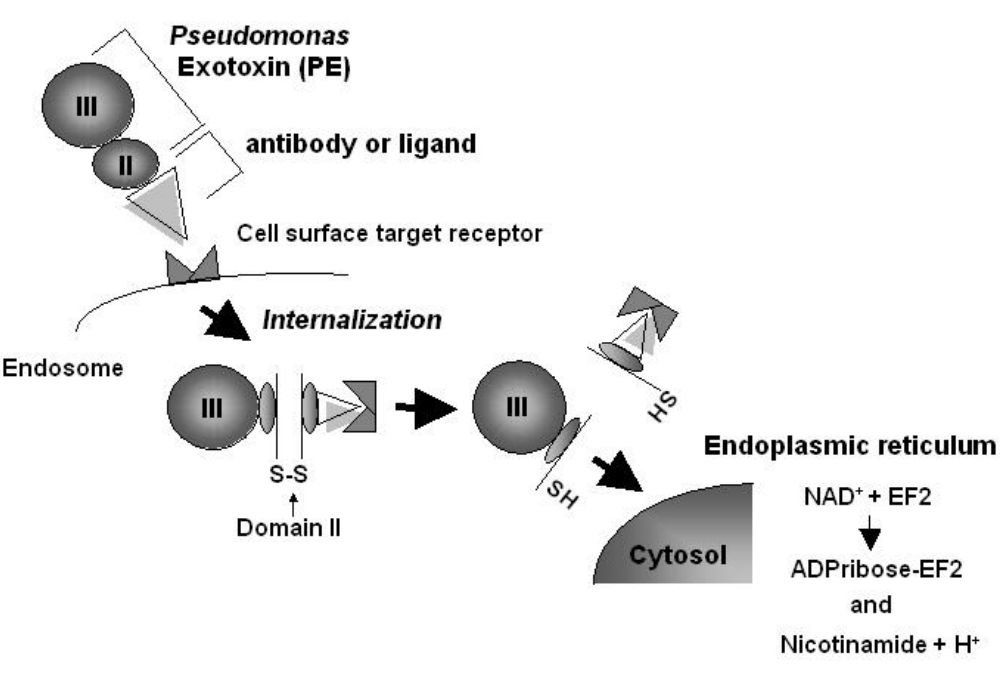
FIGURE 2 . Cytotoxic mechanism of PE-based immunotoxin. The low-pH environment in the endosome causes unfolding of the immunotoxin at domain II. The carboxyl terminal fragment containing domain III, the ADP ribosylation domain, is transferred into the endoplasmic reticulum, then finally into the cytosol. It inhibits protein synthesis of targeted cells by irreversible ADP ribosylation of elongation factor (EF)-2, utilizing NAD + as a cofactor, resulting in cell